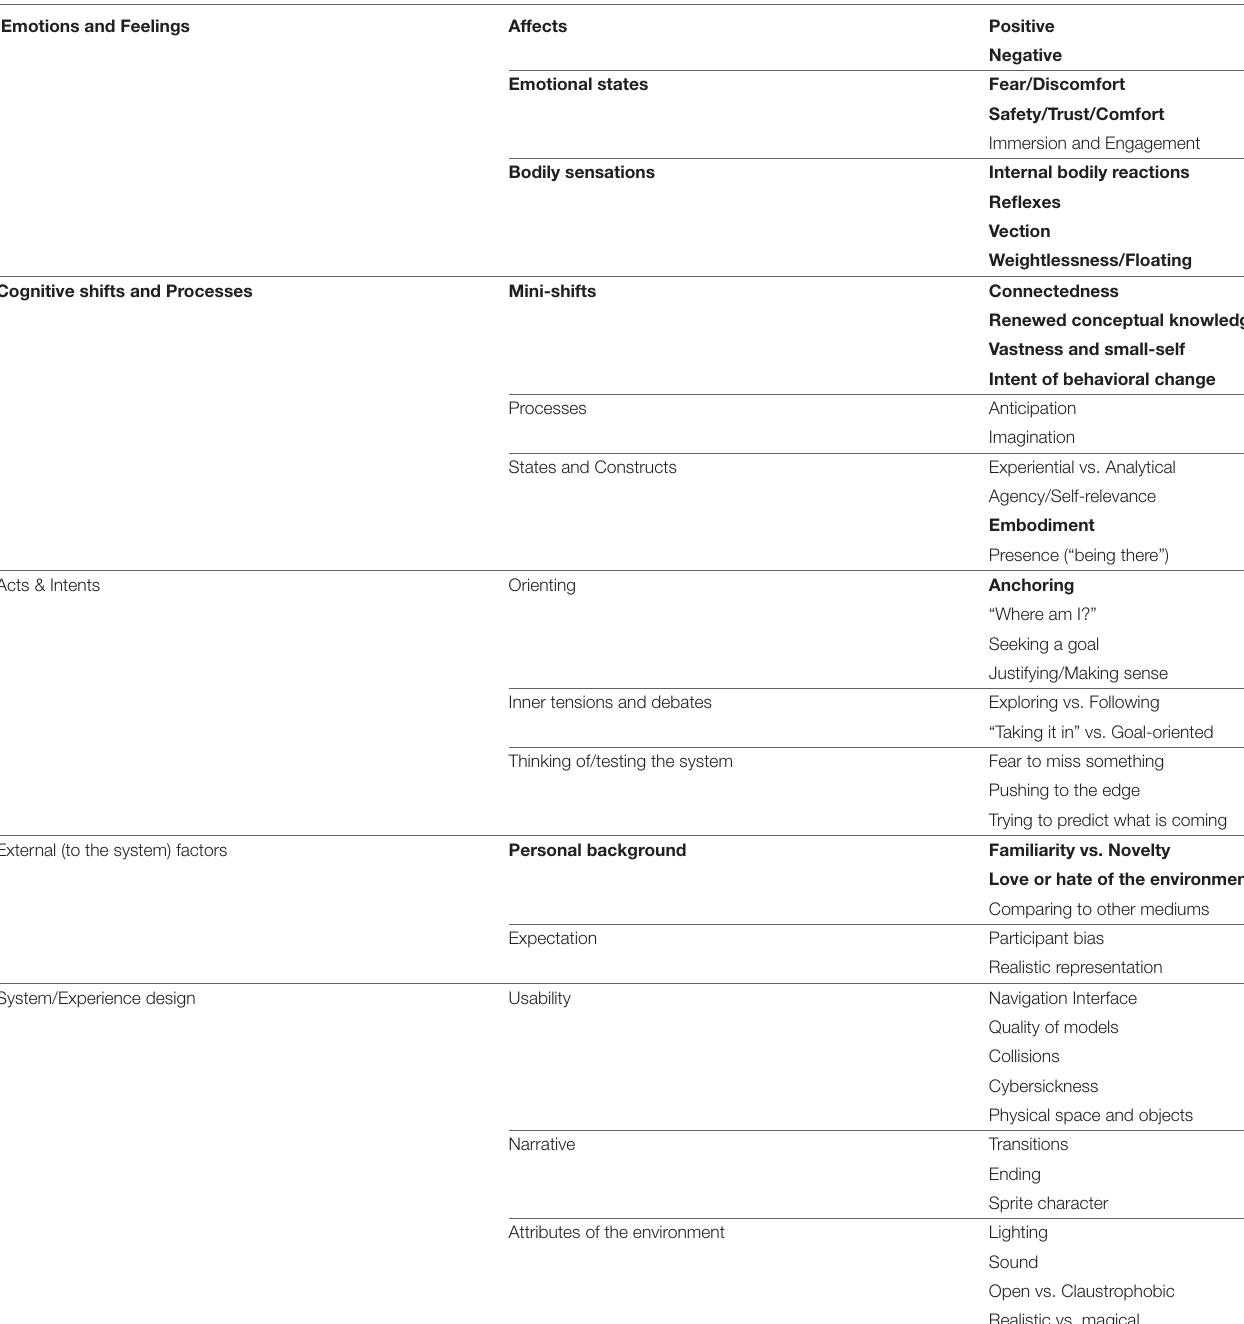
TABLE 1 | Comprehensive summary of themes coded in the interview data, with the prominent themes reported in this chapter